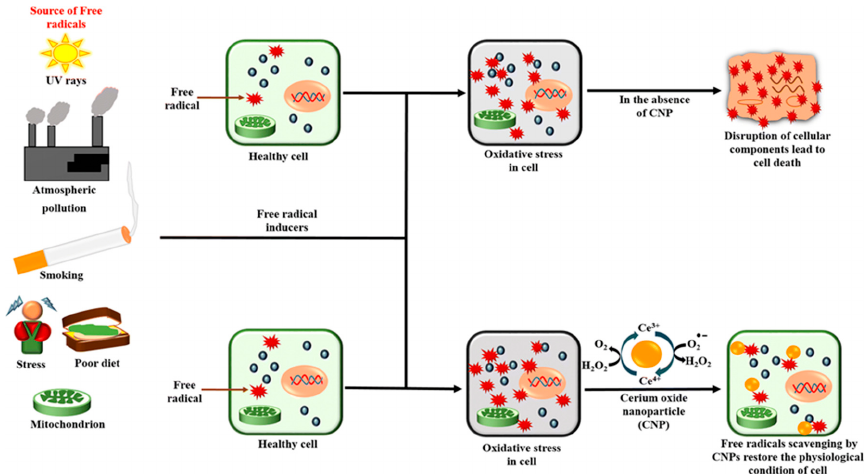
Figure 2. A depiction of some of the causes of oxidative stress and the redox action of cerium